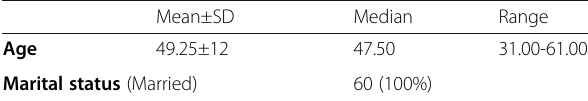
Table 1 Distribution of seciodemographic data among studied group